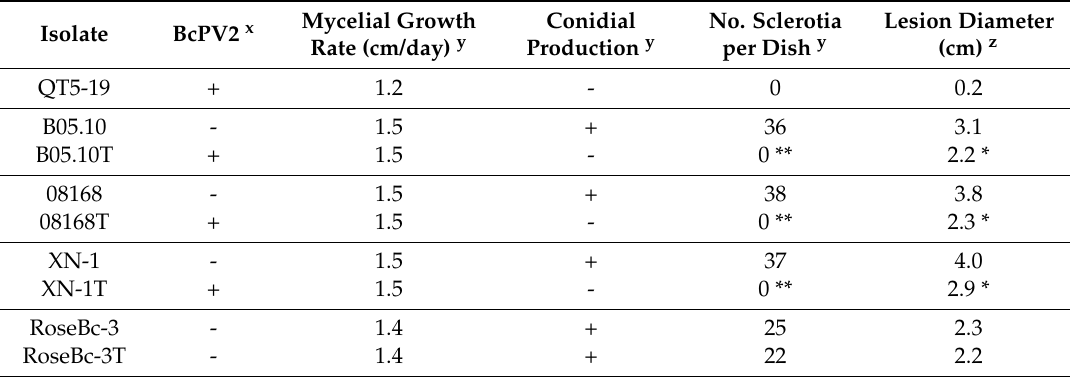
Table 2. Horizontal transmission of BcPV2 from QT5-19 to isolates of B. cinerea (B05.10, 08168, RoseBc-3, and pathogenicity of the